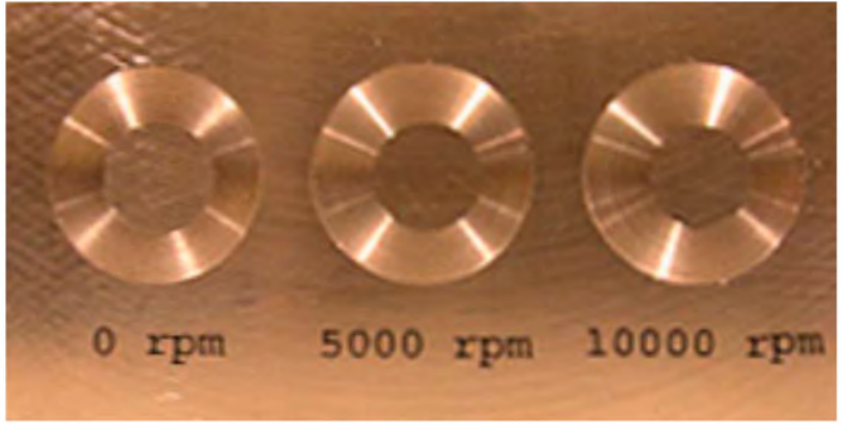
Figure 44. Machining marks at different rotational speeds